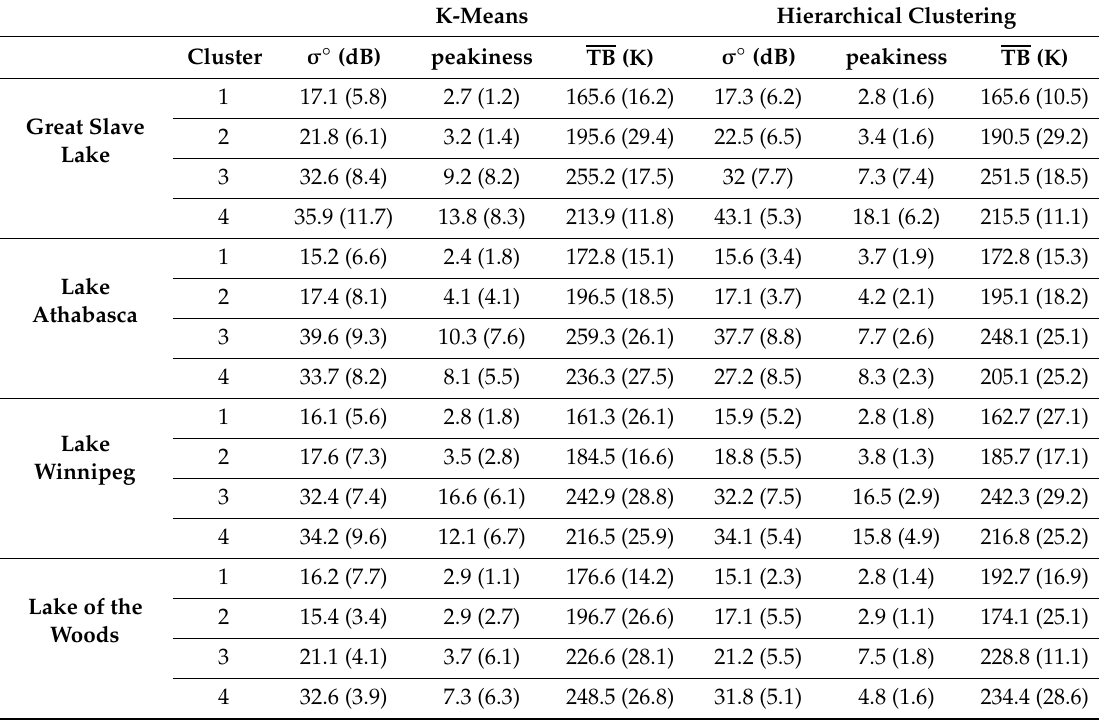
Table 3. Thresholds defined for each class depending upon the clustering technique. The centre of the class and associated deviation are indicated. The clusters 1, 2, 3, or 4 correspond to one of these classes: open water, ice cover, ice break-up, or ice